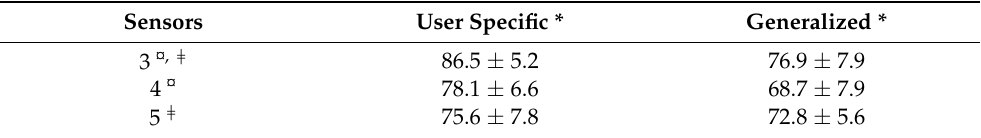
Table 6. Classification results for different sensor combinations when assessing model performance using varying sensor placements after training the model based on the data of sensor location 3. Shown are mean accuracies (%) and the corresponding standard deviation of all seven subjects when developing user-specific or generalized models.